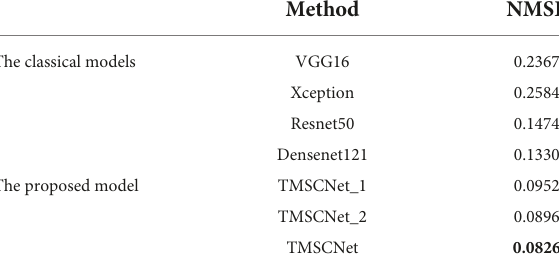
TABLE 7 NMSE values of the estimated lettuce traits by different classical CNNs and